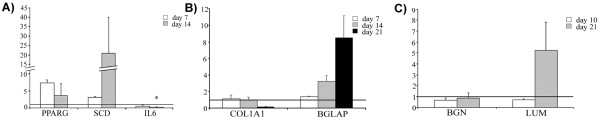
Quantitative real time PCR analysis. Expression of the adipogenic (A), osteogenic (B) and chondrogenic (C) markers at different times of the differentiation process relative to the levels observed in control cultures (values set to 1, horizontal line). Data are shown as mean ± standard errors. Statistically significant differences between differentiated and control cells were determined by Student t test (*P < 0.05).